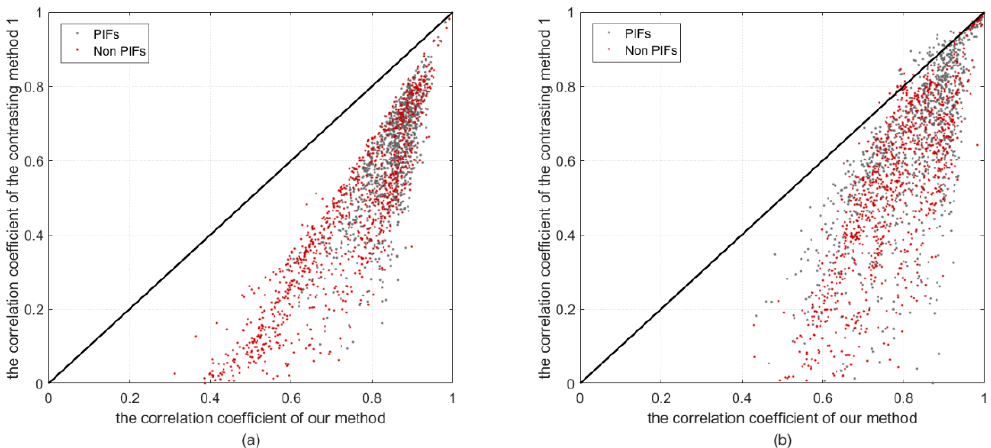
Figure 12. The correlation coefficient comparison of two experiments; ( a , b ) represent the results of exp1 and exp 2, respectively. The abscissa axis represents the correlation coefficient between the time-series Top of Atmosphere (TOA) reflectance and the normalized gray-scale value obtained by our method, and the longitudinal axis indicates the correlation coefficient between the time-series TOA reflectance and the normalized gray-scale value obtained by our contrasting method 1.